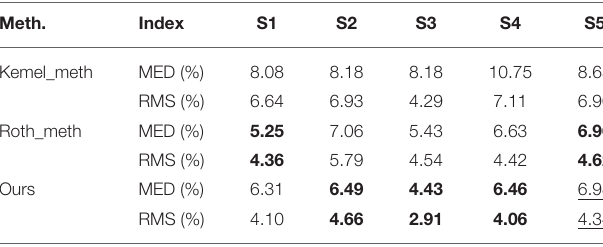
TABLE 1 | Distances of the reconstruction to the ground truth.